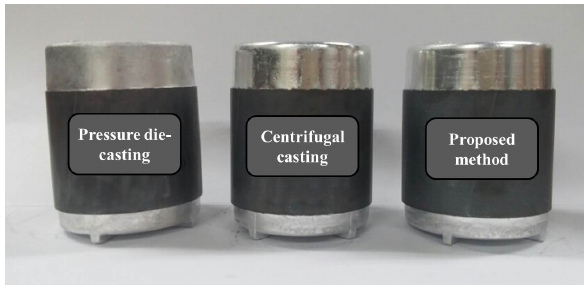
Figure 7. Prototype rotors according to the casting method.